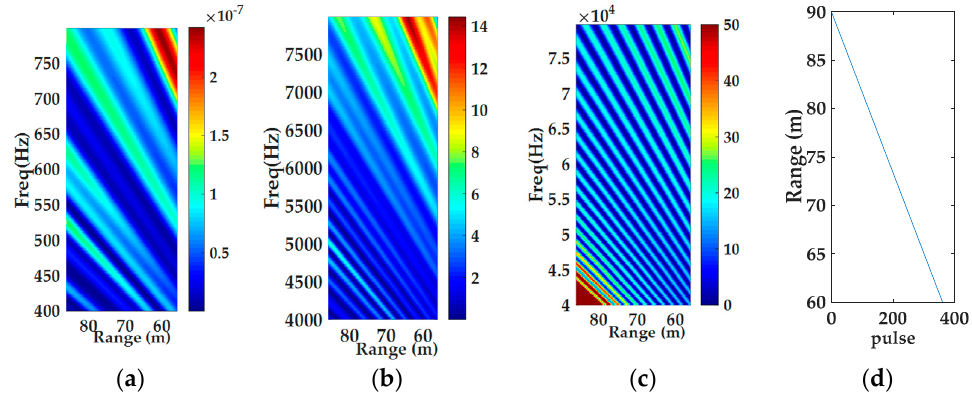
Figure 3. The simulation results in the monostatic configuration: ( a ) the interference pattern for 400 − 800 Hz; ( b ) the interference pattern for 4 − 8 kHz; ( c ) the interference pattern for 40 − 80 kHz; ( d ) the motion trajectory.